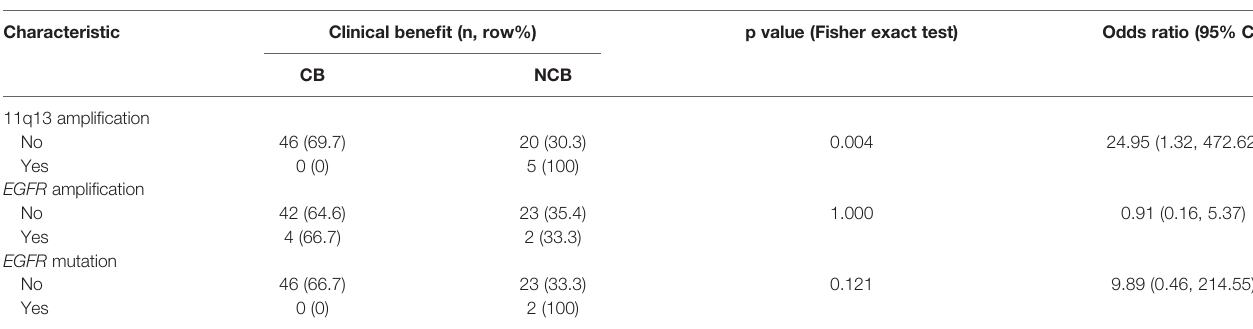
TABLE 3 | Subgroup analysis of patients with CPS ≥ 1. Characteristic